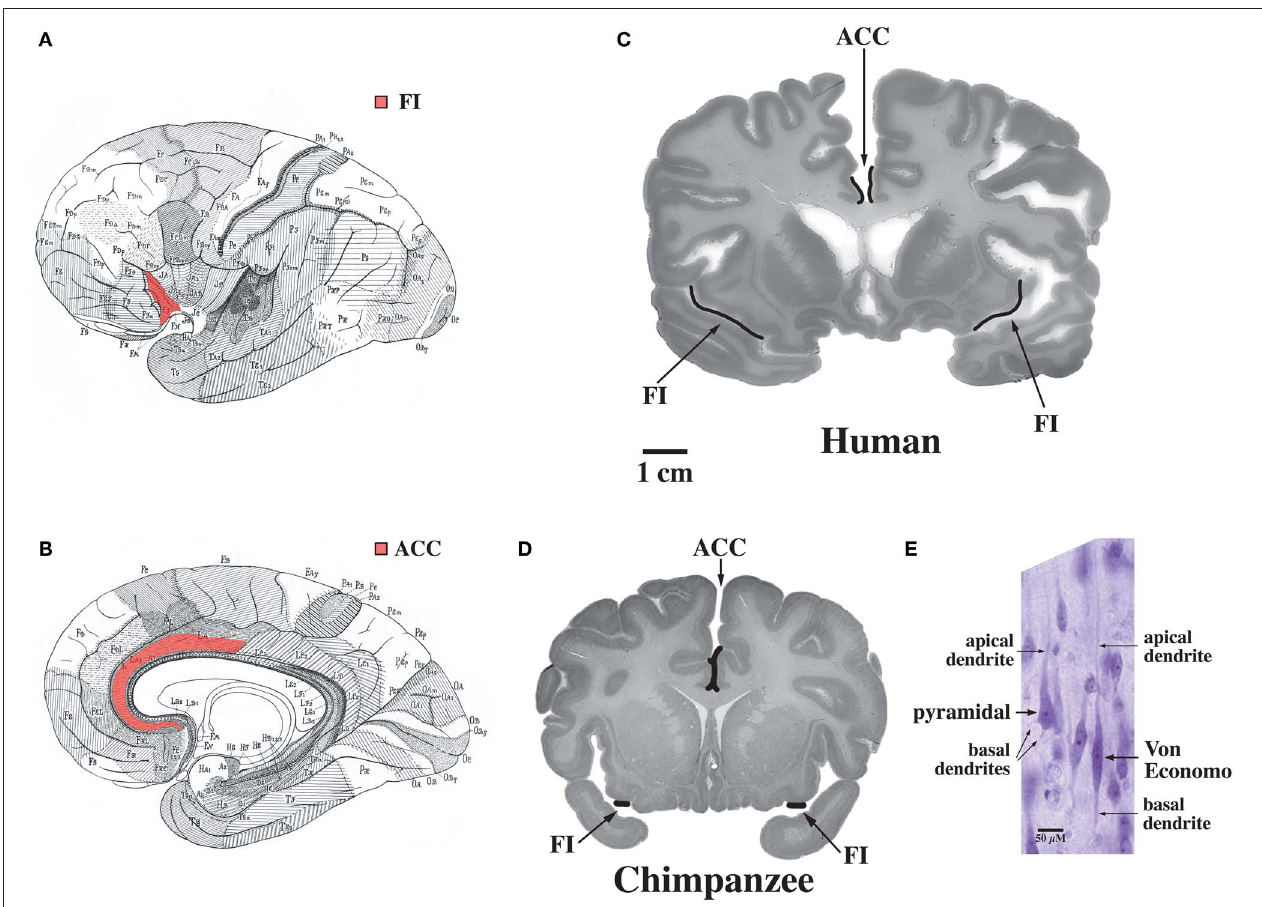
in the chimpanzee. (E) A Von Economo neuron and a pyramidal neuron in layer 5 of FI. Both types of neuron have a single apical dendrite, but note that the VEN also has only a single basal dendrite, in contrast to the pyramidal neuron’s multiple basal dendrites. Photomicrograph by the authors of a section from the 50-year-old human brain shown in part (C) . Reprinted from Allman et al. Intuition and autism: a possible role for Von Economo neurons. Trends Cogn. Sci. 9, 367–373, Copyright 2005, with permission from